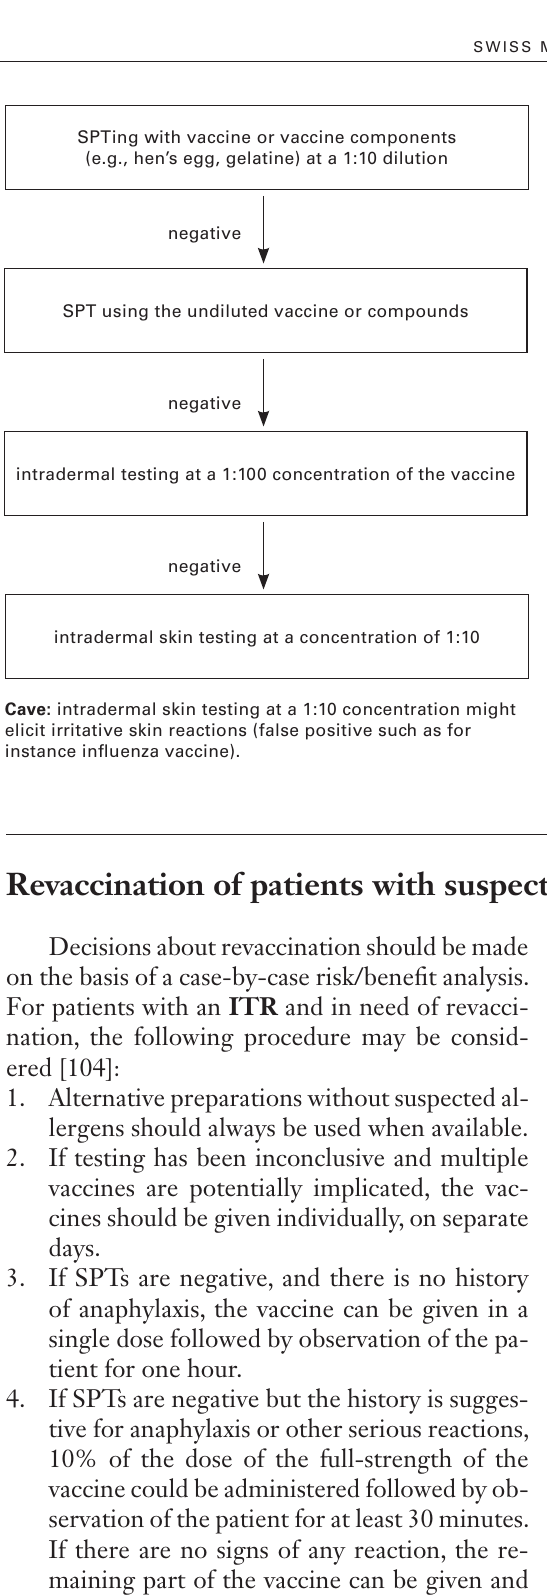
SPTing with vaccine or vaccine components (e.g., hen’s egg, gelatine) at a 1:10 dilution